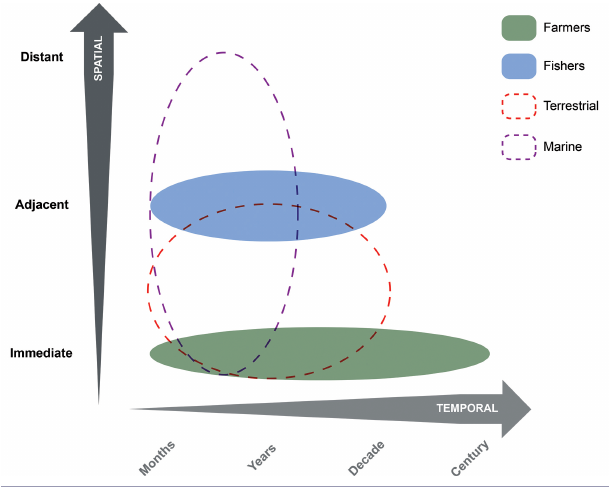
Fig. 6 . Different knowledge strands, namely local knowledge of farming and fishing communities in the southern Cape and terrestrial and marine scientific data, examined over varying temporal and spatial scales. Spatial scale can be described as immediate (farm or specific location on the coast), adjacent (catchment or bay), and distant (southern Cape region or Agulhas